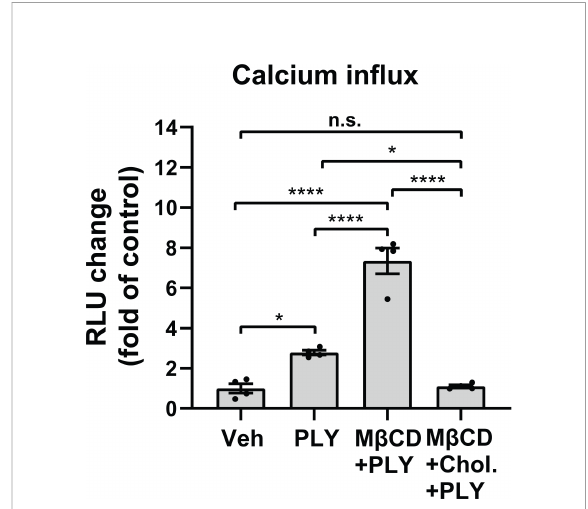
FIGURE 1 Membrane cholesterol paradoxically inhibits PLY-induced calcium- entry. Membrane cholesterol was either depleted (M b CD) or loaded (M b CD+Chol.) into the plasma membrane of COS7 cells for 30 minutes, followed by a 10 minutes treatment with vehicle (Veh) or PLY (60 ng/mL) and changes of intracellular calcium levels were measured by aequorin-mediated luminescence as described in materials and methods. Data are represented as mean ± SE, n.s., not signi fi cant, *P<0.05, ****P<0.0001 (n=4). One-way ANOVA (with Tukey ’ s post-hoc